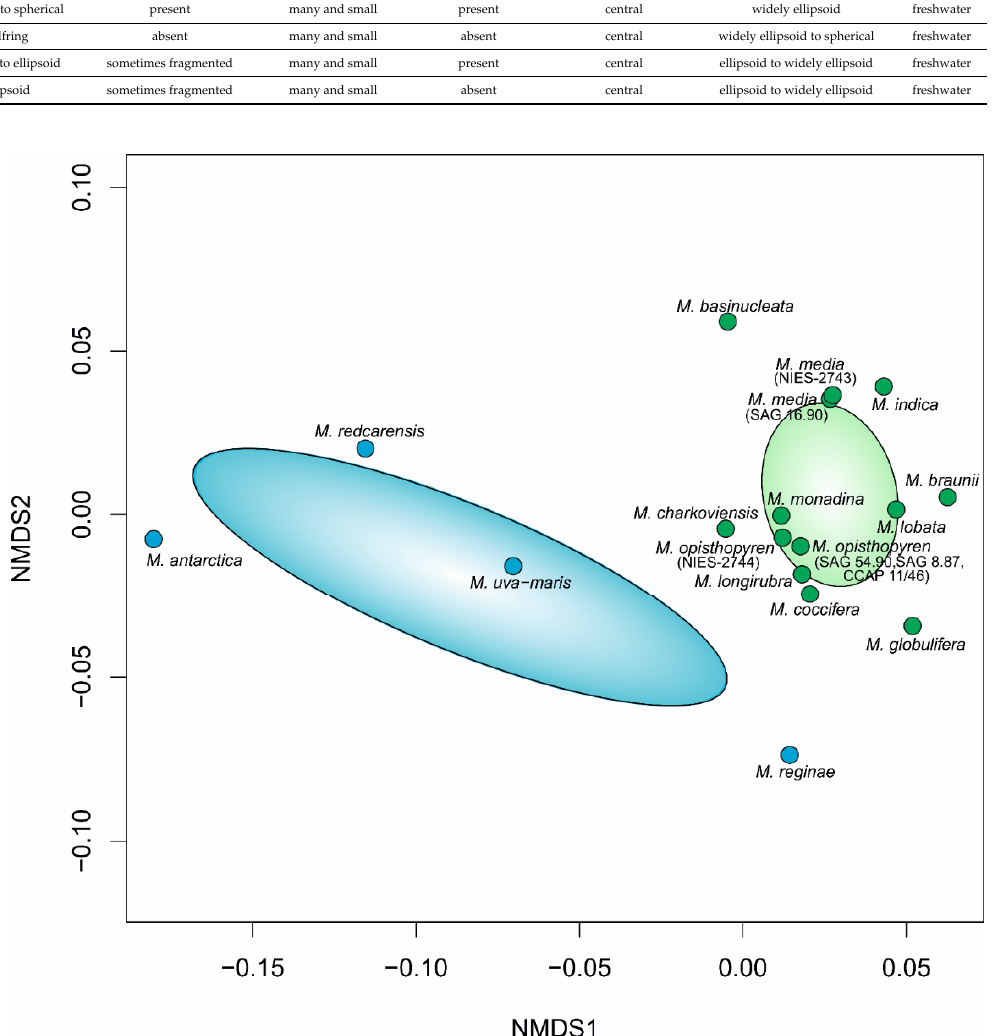
Figure 4. Non-metric multidimensional scaling of p-distances of marine (blue) and freshwater (green) Microglena species.